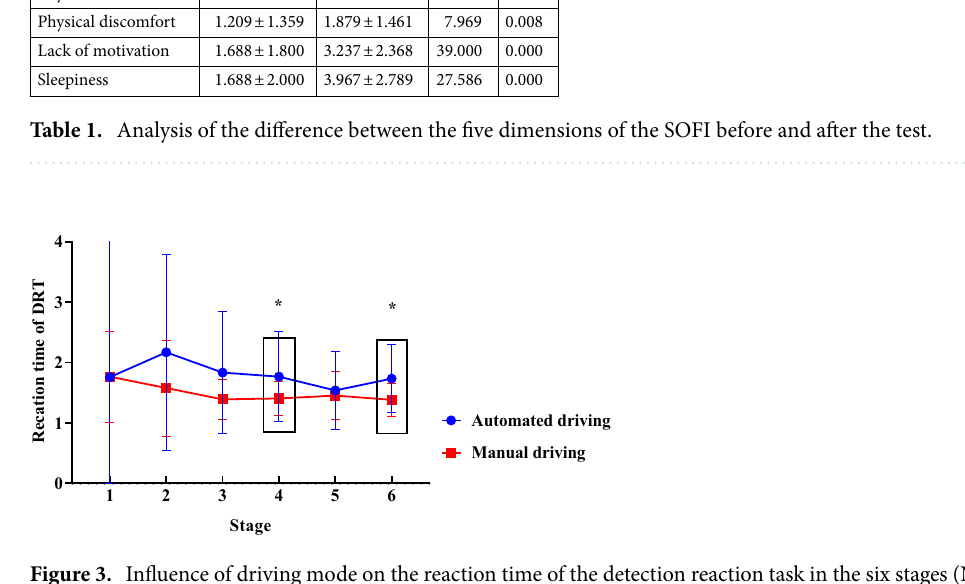
Figure 3. Influence of driving mode on the reaction time of the detection reaction task in the six stages (Note: * p <